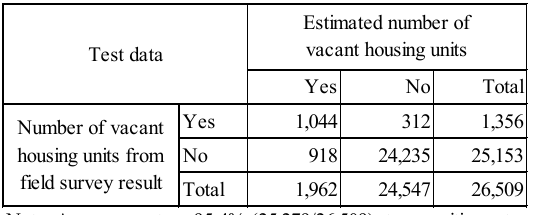
Table 3. Result of cross validation